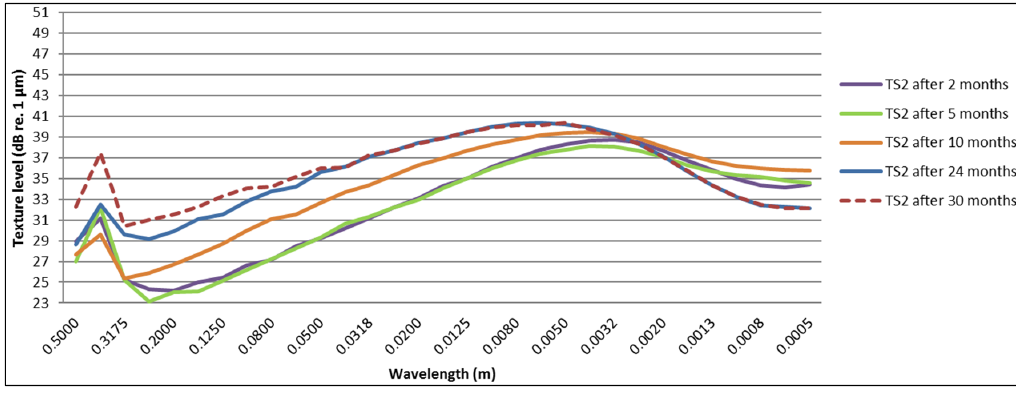
Figure 16. Change in texture spectra over a period of 30 months for Test Section 6.